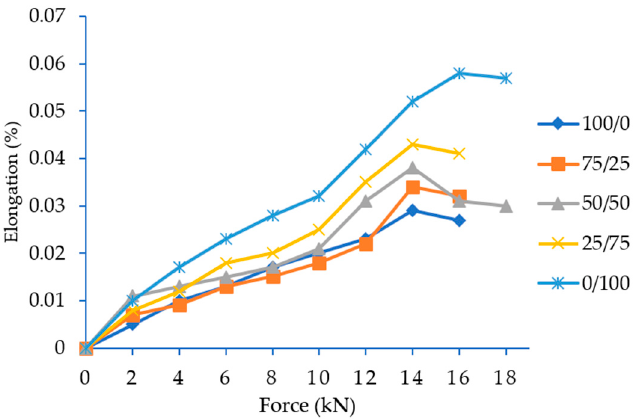
Figure 4. Force–elongation diagram for (tensile) for enset sisal hybrid composite.